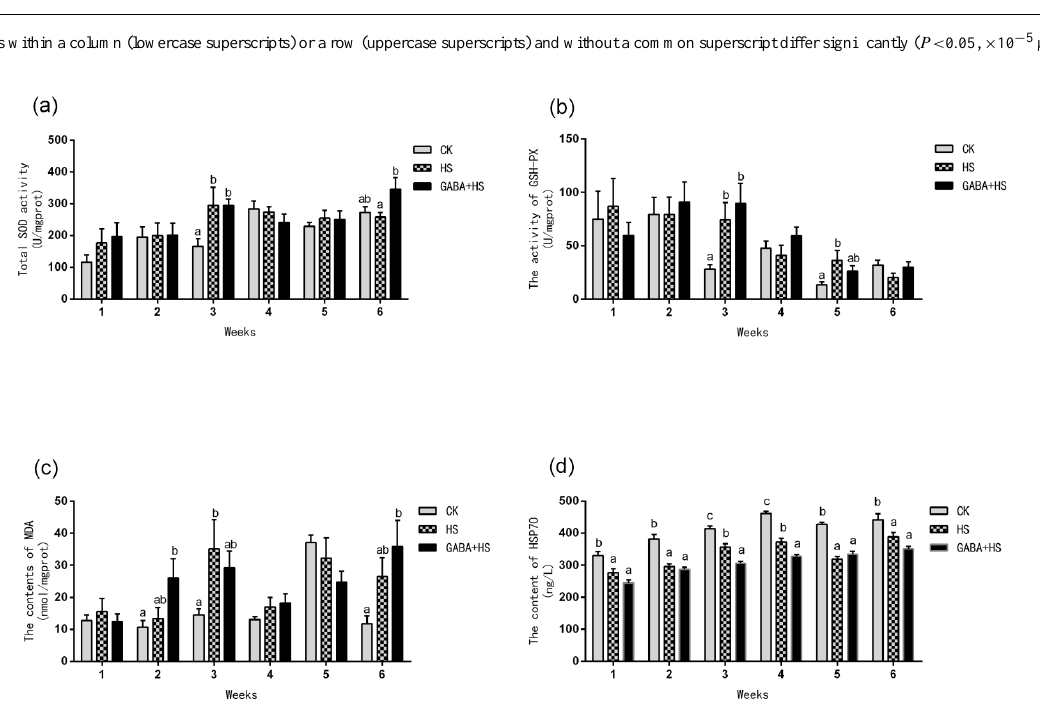
Figure 2. Effects of GABA on the activity of SOD and GSH-PX and the content of MDA and HSP70 in the BF of chicks under heat stress ( n = 6). (a) The change of total SOD activity in the BF of chicks under heat stress. (b) The change of GSH-PX activity in the BF of chicks under heat stress. (c) The change of MDA content in the BF of chicks under heat stress. (d) The change of HSP70 content in the BF of chicks under heat